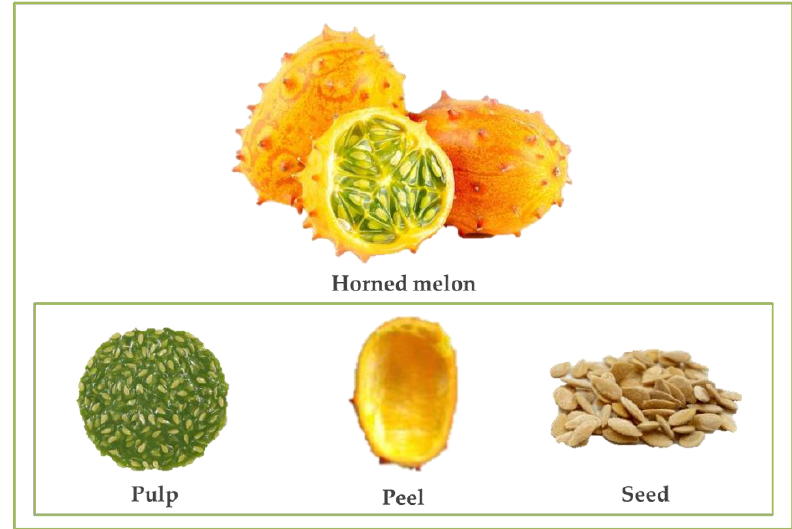
Figure 1. The main structural parts of horned melon fruit .